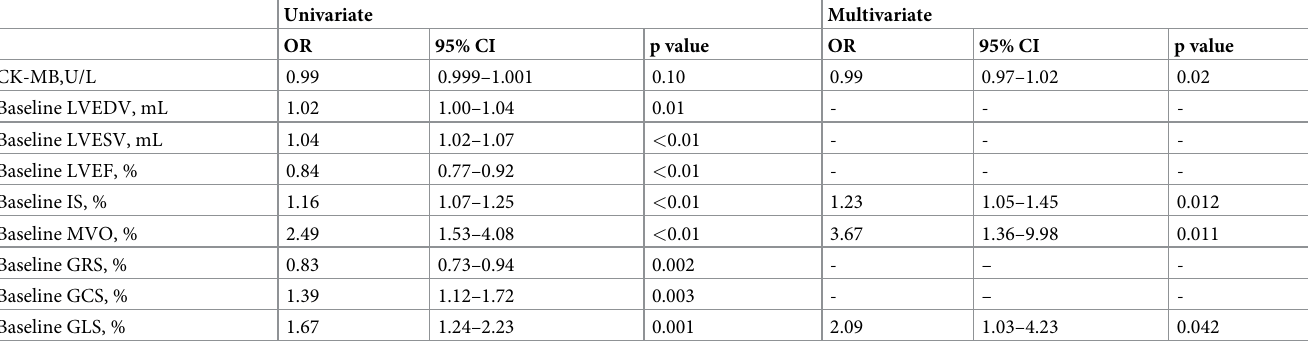
Table 3. Logistic regression analysis for the prediction of adverse cardiac